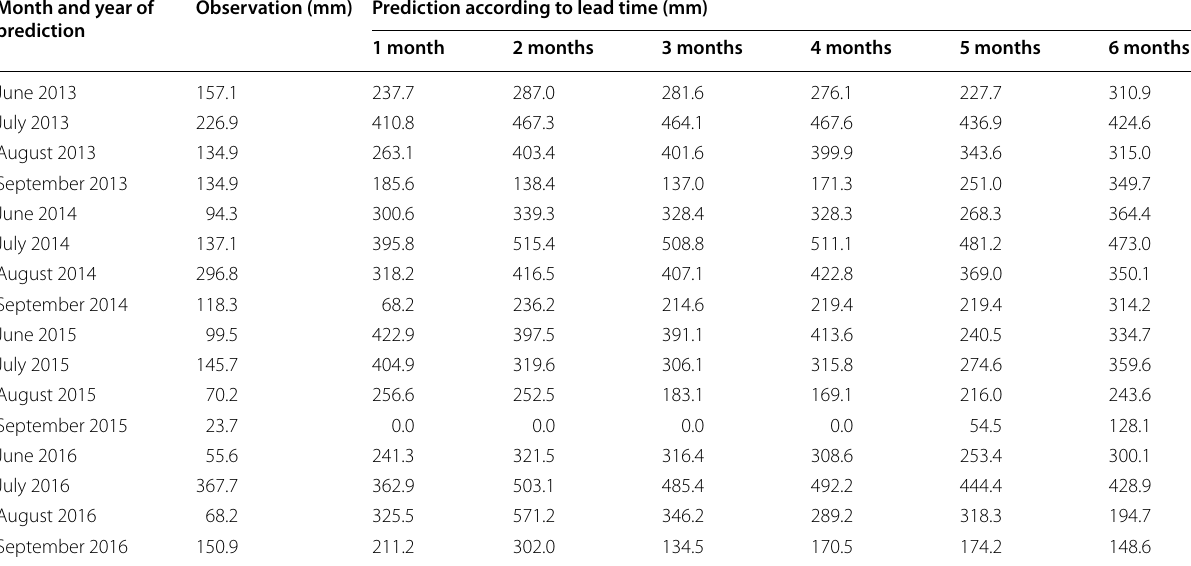
Table 10 Results of the precipitation prediction model using the modified method Month and year of Observation (mm) Prediction according to lead time (mm) prediction